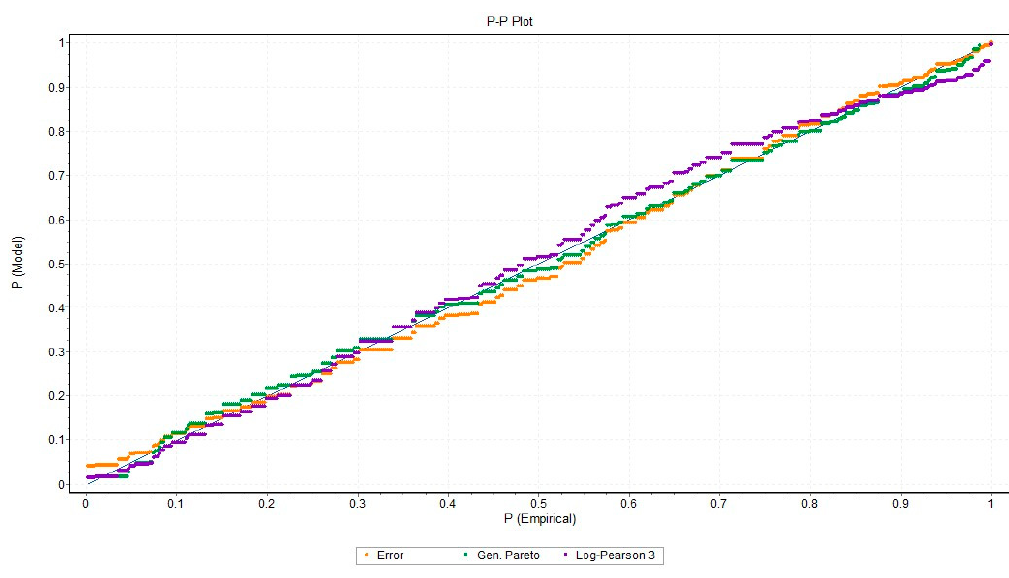
Figure 6. Probability-probability (P-P) plots of the three best fitted three-parameter distributions of c 1 for IBP with T cl = 4 years.